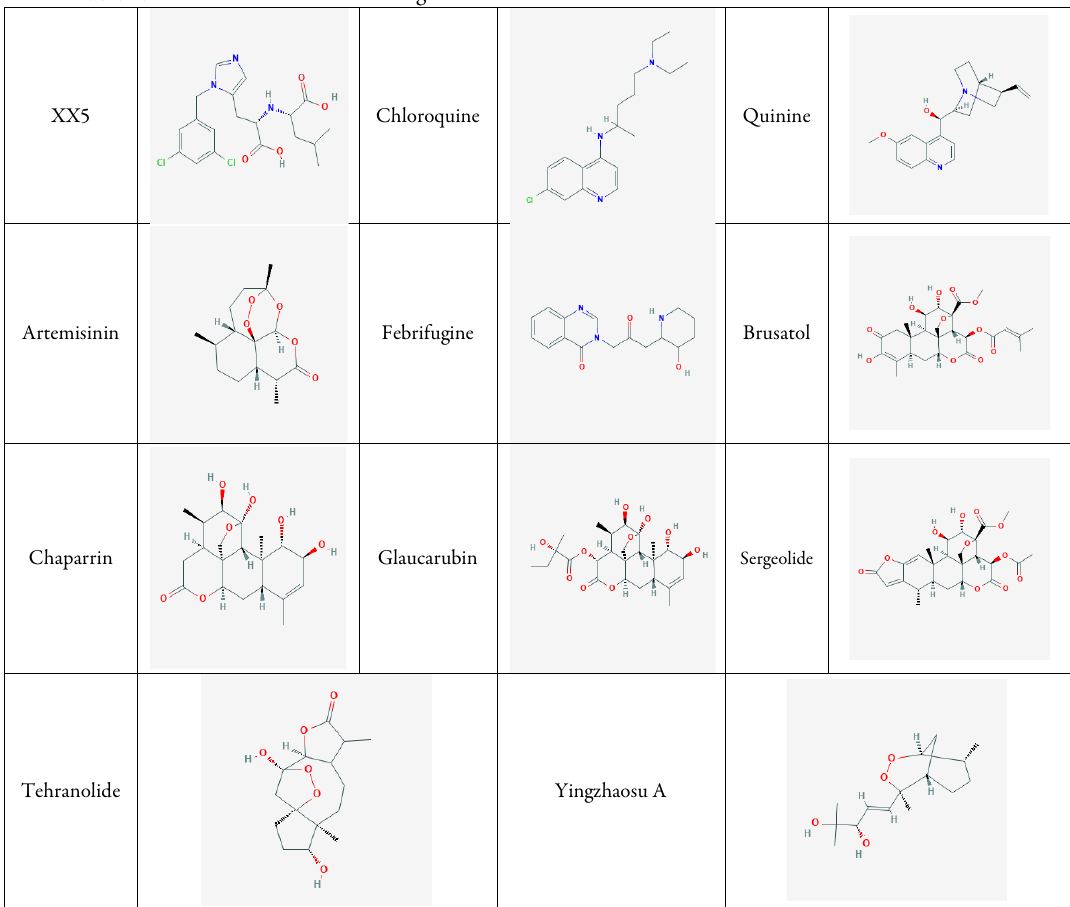
Table 1. 2D structures of the studied